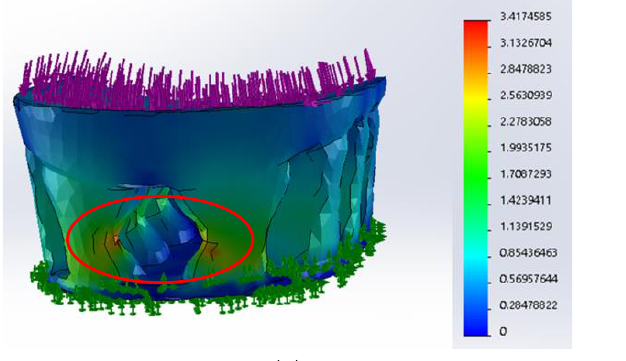
Figure 6. Results of the static analysis of designed orthopedic shoe heels from photopolymer: ( a ) distribution of the von Mises stress, MPa; ( b ) distribution of the displacements, mm. The most dan- gerous area is circled in red (load force 1000 N).